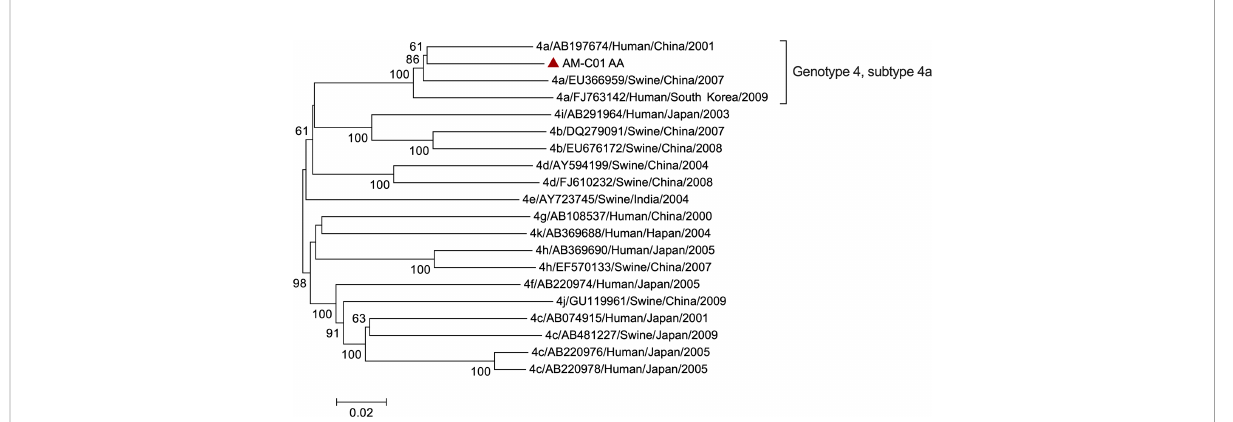
FIGURE 2 Phylogenetic tree analysis of HEV full-genome sequence in the case. The phylogenetic analysis was based on HEV full-genome. Viral genotype, GenBank accession number, virus host, country of origin, and year of detection are indicated for the reference sequences. The sequence obtained from the case is highlighted with a red triangle. The bootstrap values > 70 were